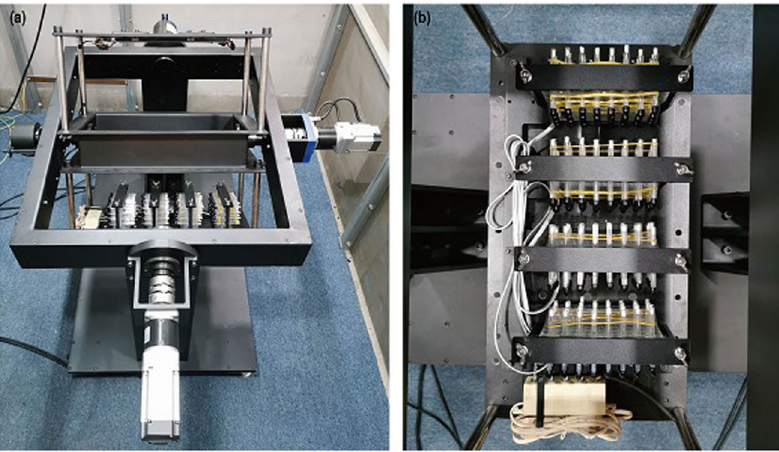
Fig. 6 Microgravity simulation system. a Random positioning machine. b Sample installation